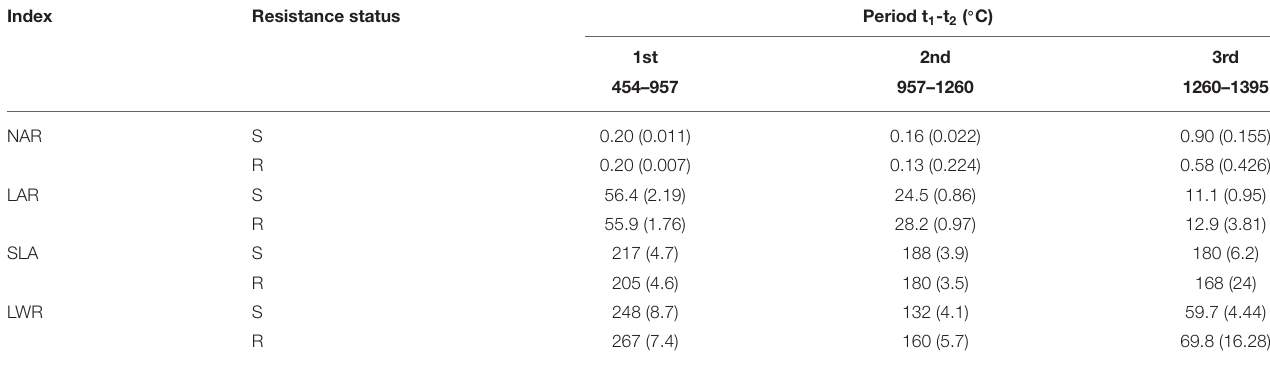
TABLE 3 | Net assimilation rate (NAR) [g cm − 2 ◦ C − 1 ], leaf area ratio (LAR) [cm 2 g − 1 ], specific leaf area (SLA) [cm 2 g − 1 ] and leaf weight ratio (LWR) [g g − 1 ] recorded in Exp2 in relation to the resistance status, S and